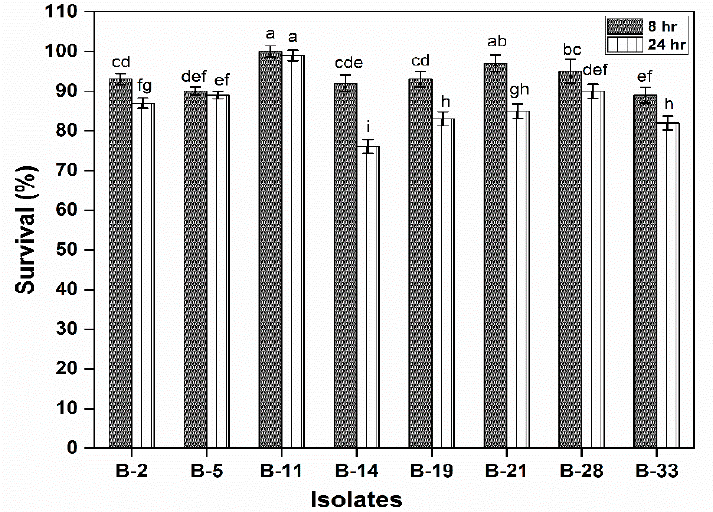
Figure 5. Cytotoxicity to observed the survival (%) of isolates after 8 h and 24 h of incubation. Each value represents the mean value ± standard deviation (SD) ( n = 3). Bars with different lower-case letters denoted significantly different ( p < 0.05).